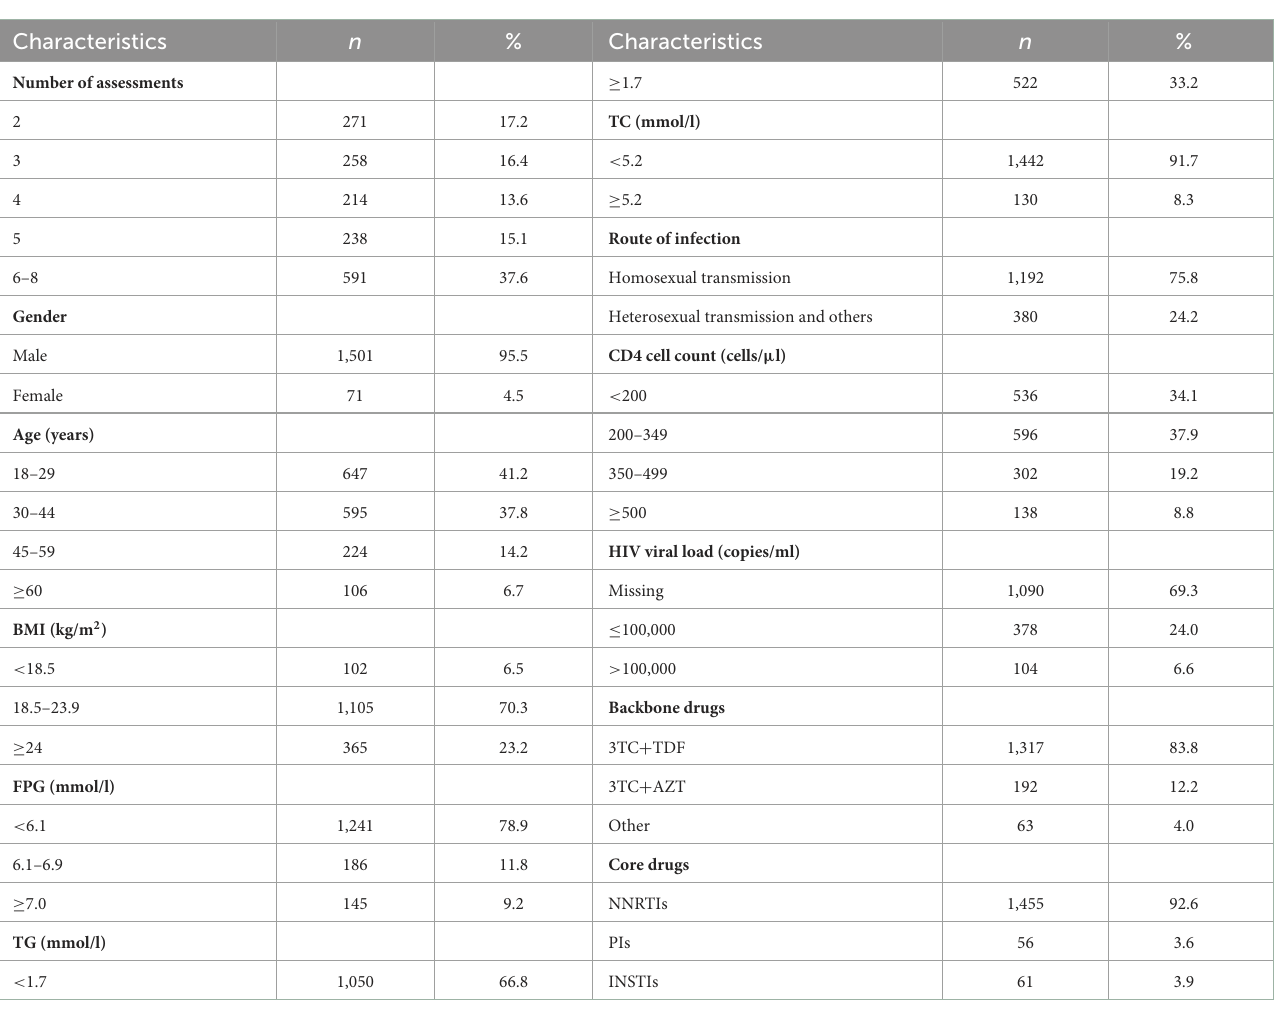
TABLE 1 Characteristics of the study population ( n =